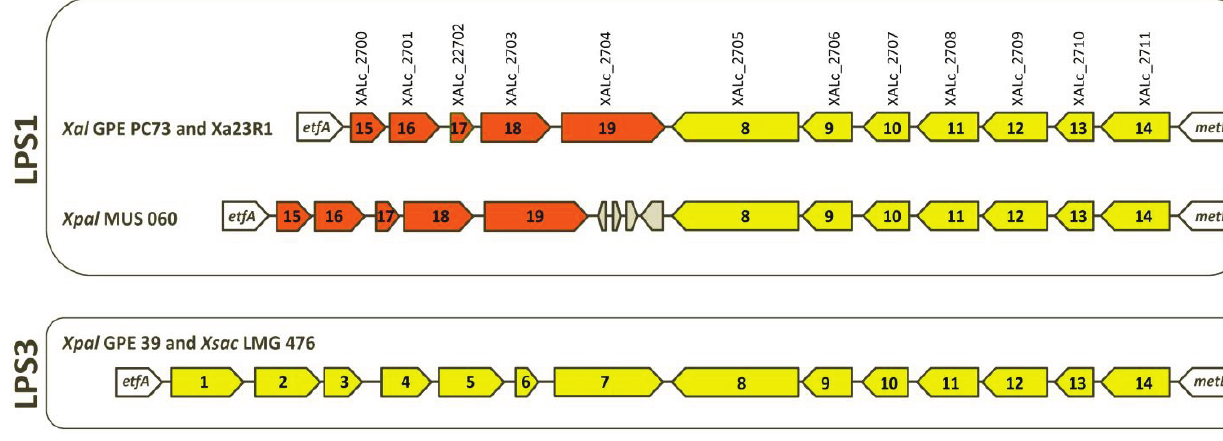
Figure 3. Schematic comparison of LPS loci of strains of X. albilineans ( Xal GPE PC73 and Xal Xa23R1), “ X. pseudalbilineans ” ( Xpal GPE 39 and Xpal MUS 060) and X. sacchari ( Xsac LMG 476). An arrow with a same color and a same number represents an identical gene. Grey-colored arrows are transposase